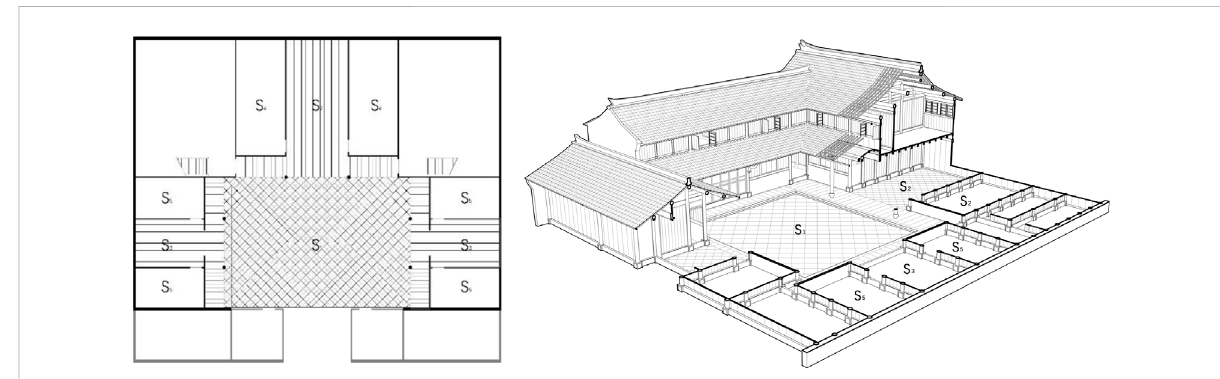
FIGURE 2 The ideal layout of traditional courtyard house in South China.